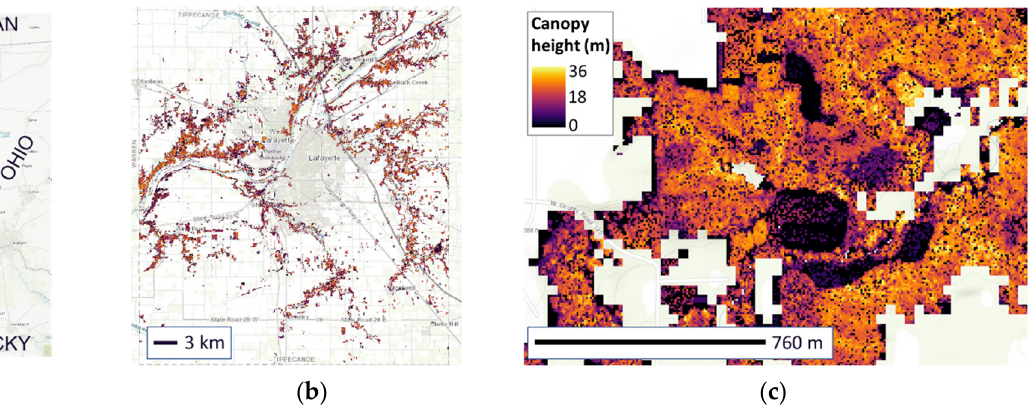
Figure 8. Visualization of ( a ) canopy height model (CHM) of Indiana, USA, ( b ) CHM in Tippecanoe County, Indiana, USA, and ( c ) CHM in Martell Forest in Tippecanoe County, Indiana, USA.